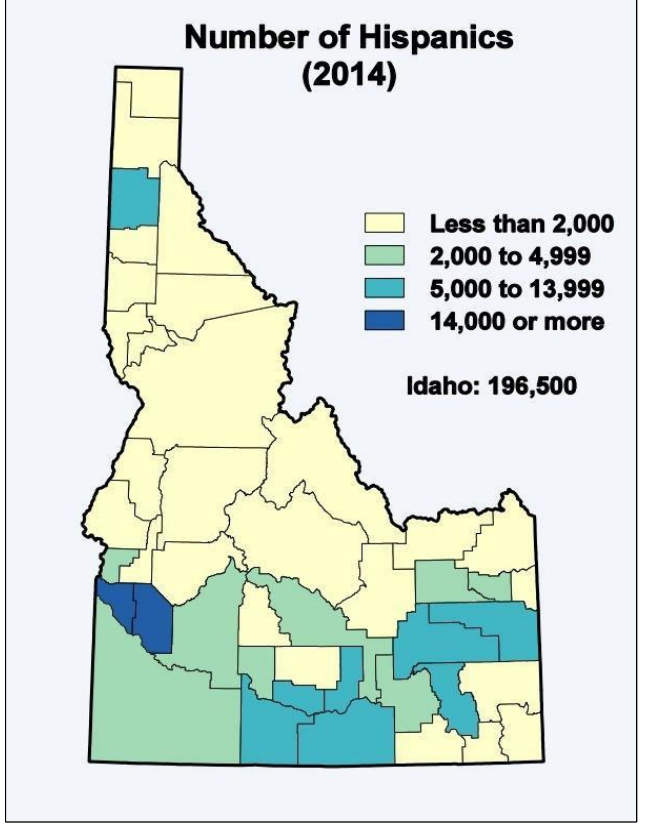
Source: University of Idaho McClure Center for Public Policy,